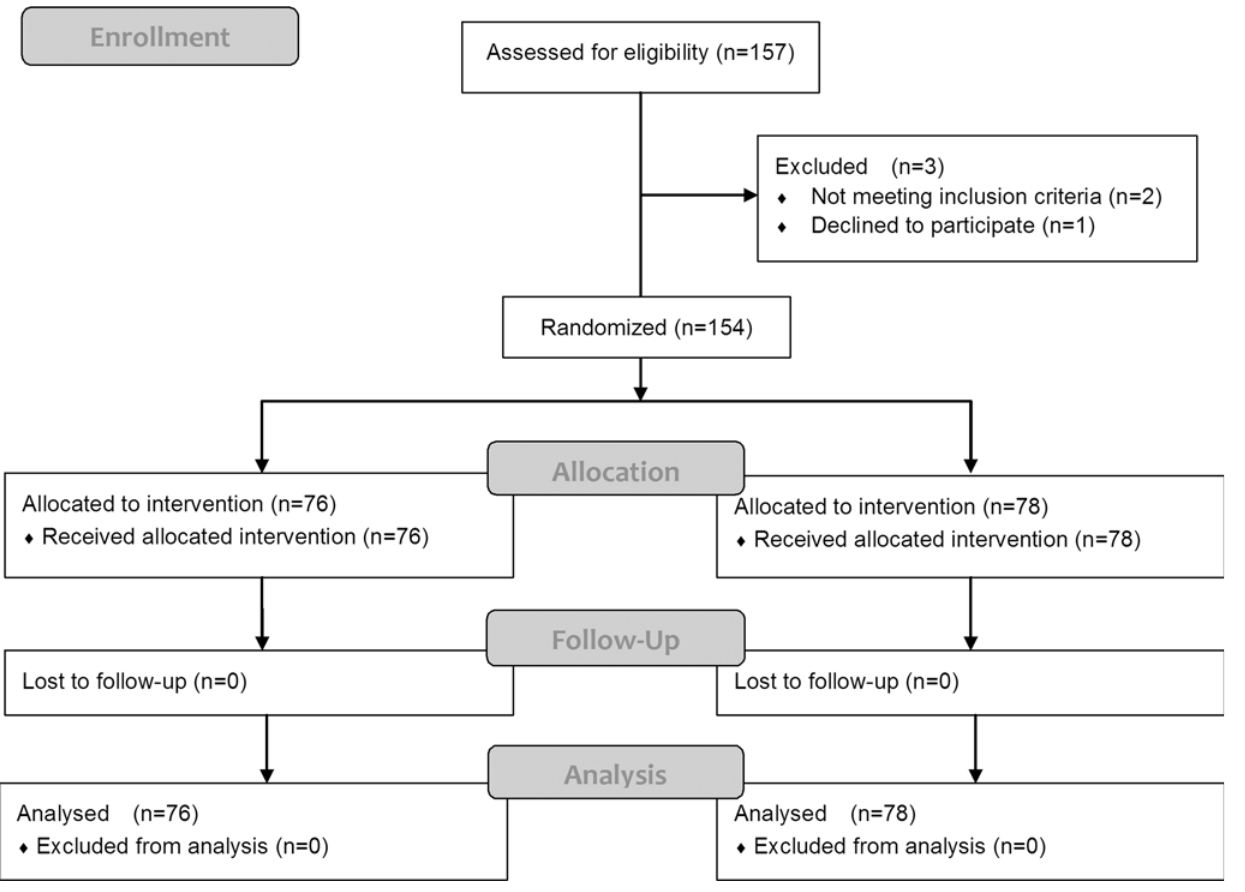
Fig 1. CONSORT flow chart of patient sample selection.